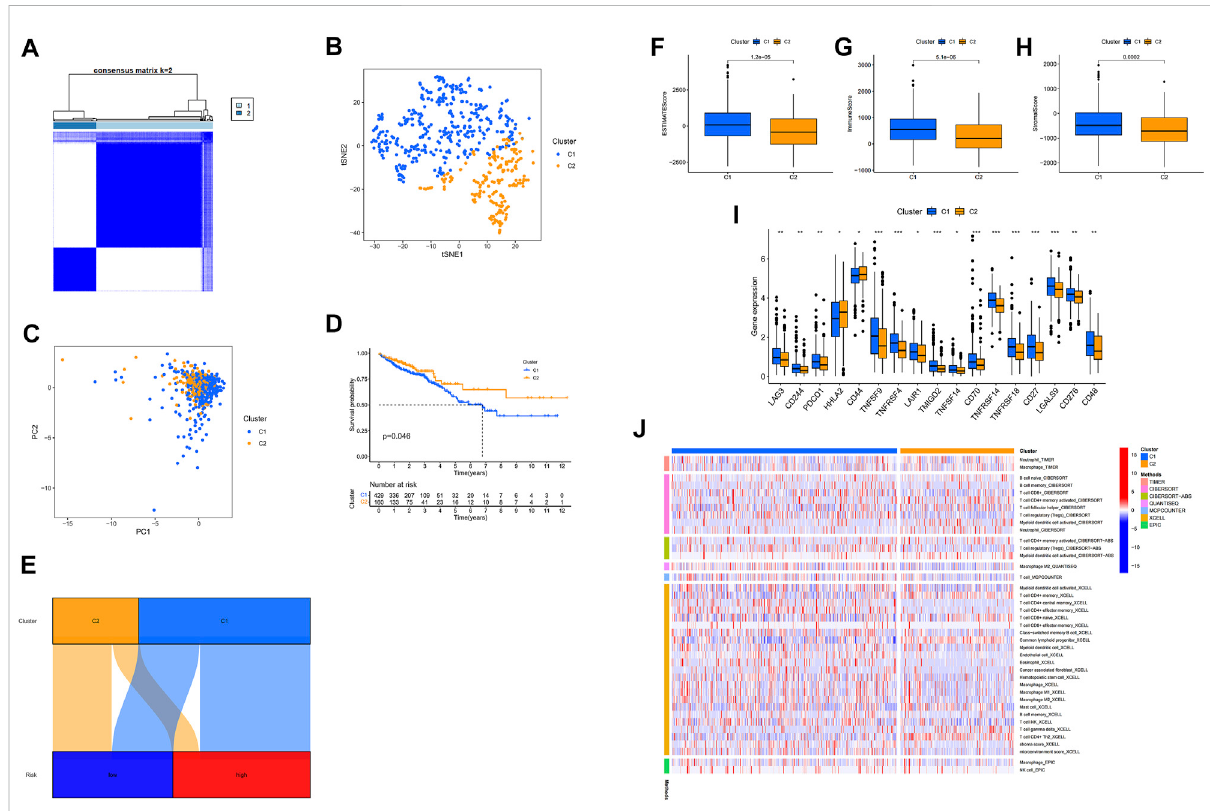
FIGURE 7 Identifyingcoldandhottumorsandpredictingtheirresponsetoimmunotherapy. (A) TheConsensusClusterPlusalgorithmdividespatientsinto two clusters. (B) Two clusters of t-SNE. (C) PCA of clusters. (D) Based on Kaplan-Meier survival curves, OS survival curves for clusters of patients. (E) Cluster analysis of risk groups. (F – H) Scores in immune-related categories between clusters 1 and 2 are compared. (I) The difference between 32 checkpoint expressions in clusters. (J) Clusters of immune cells on a heat